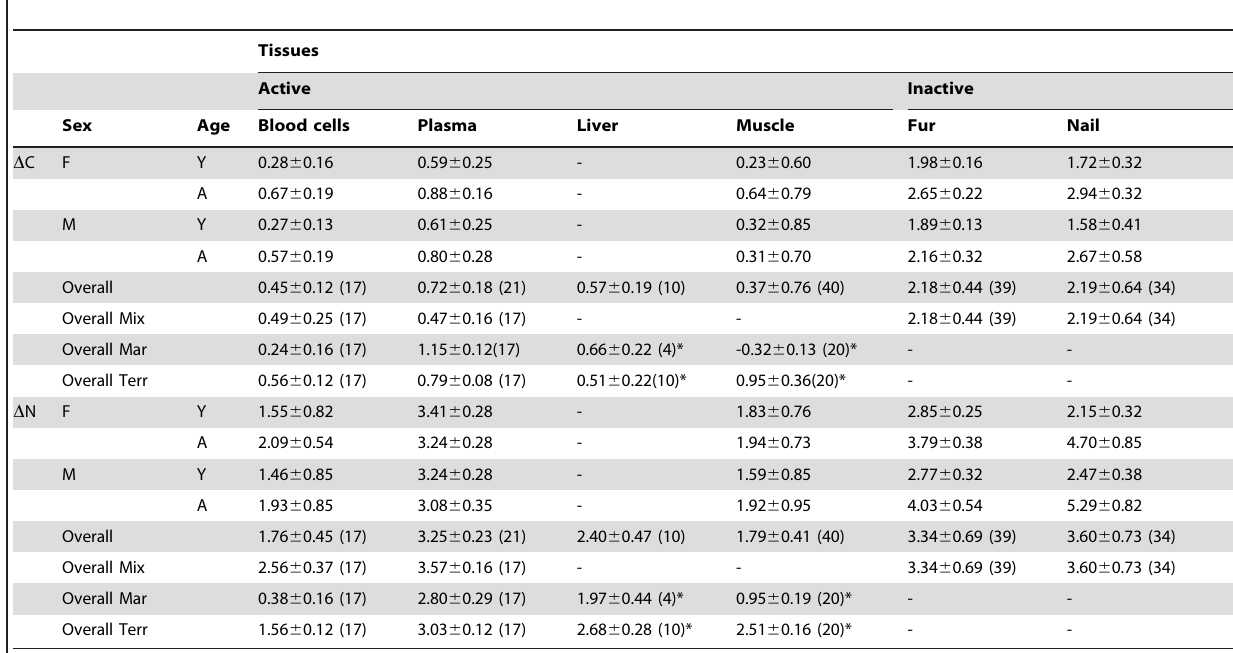
Table 1. Mean discrimination factors 6 SD ( % ) between experimental diet and tissues of arctic